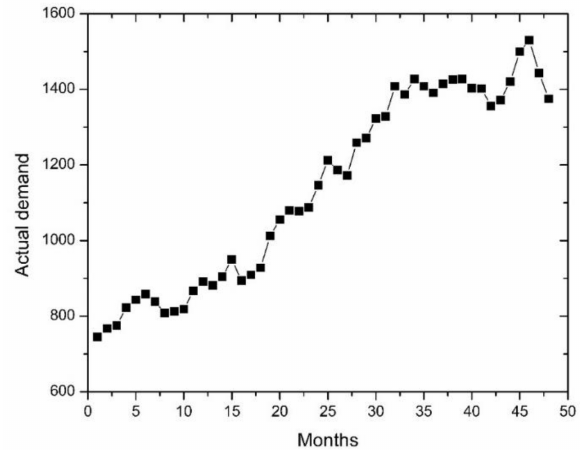
Figure 9. Monthly demand data for plastic bags. Adapted from